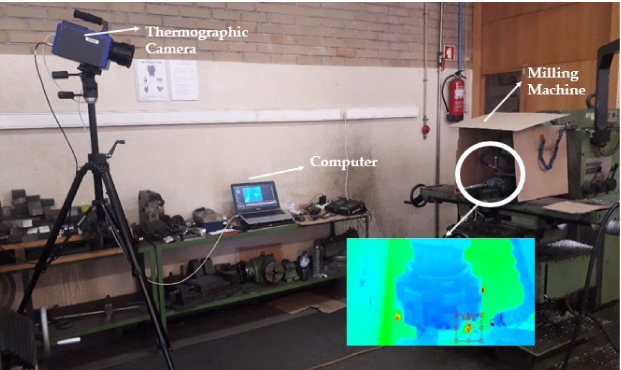
Figure 3. Test setup for the chip temperature analysis via ResearchIR Max software.